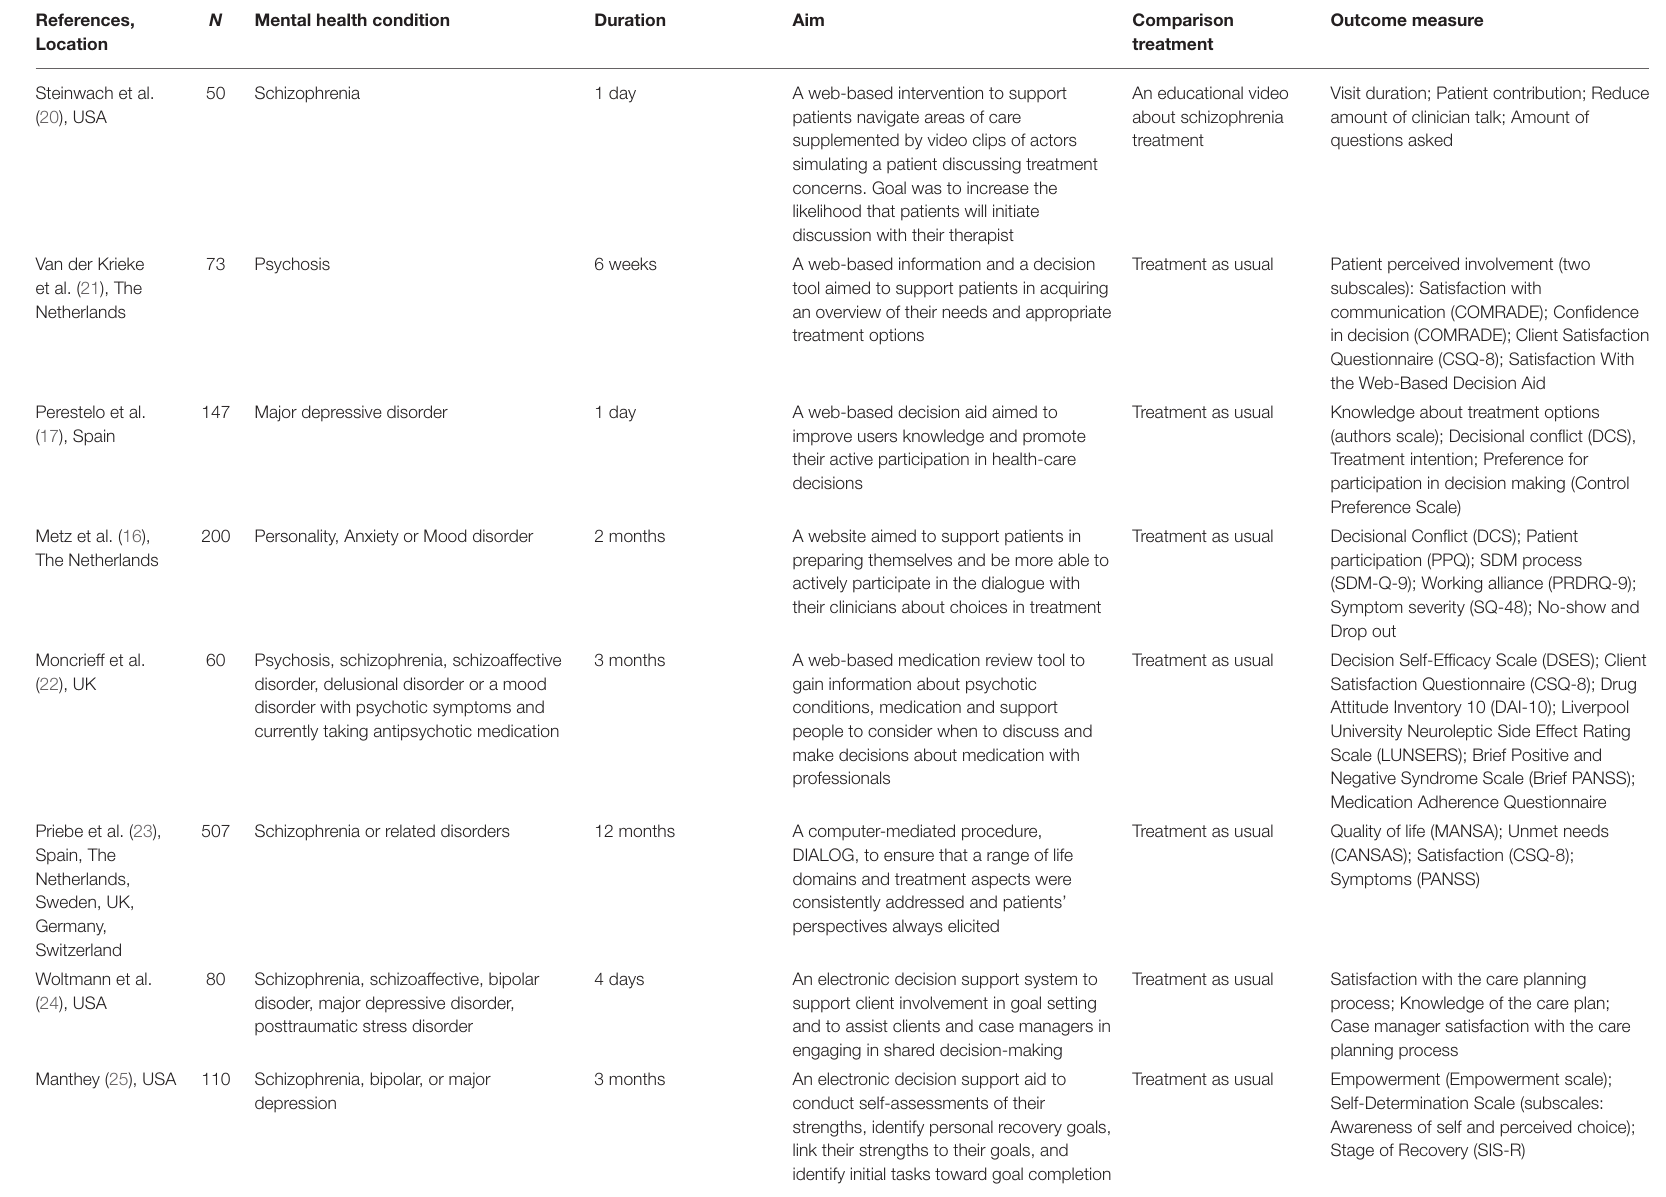
TABLE 1 | Characteristics of the 16